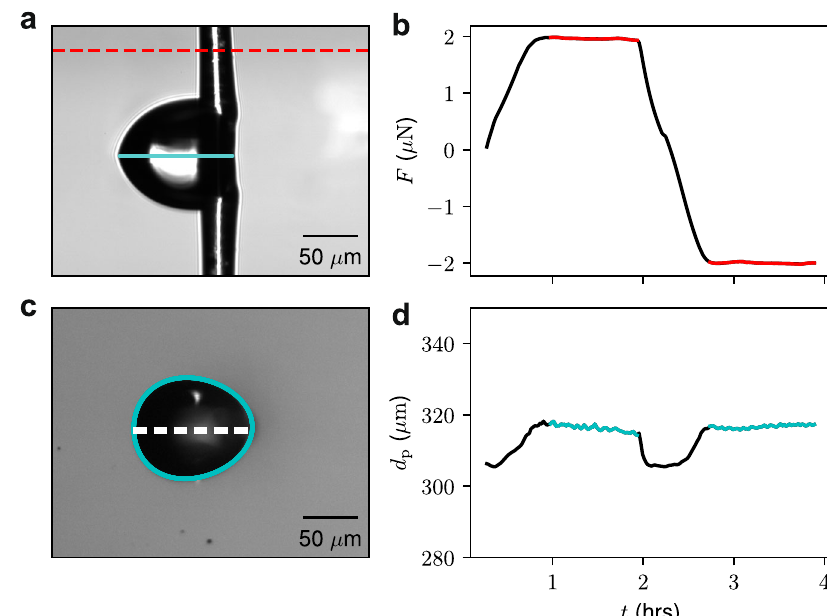
the micropipette de fl ection. b The force required to maintain the droplet in a fi xed position as the substrate is translated back and forth as a function of time. The force forasetspeed, v , istaken from theplateauvalues indicatedinred. c A